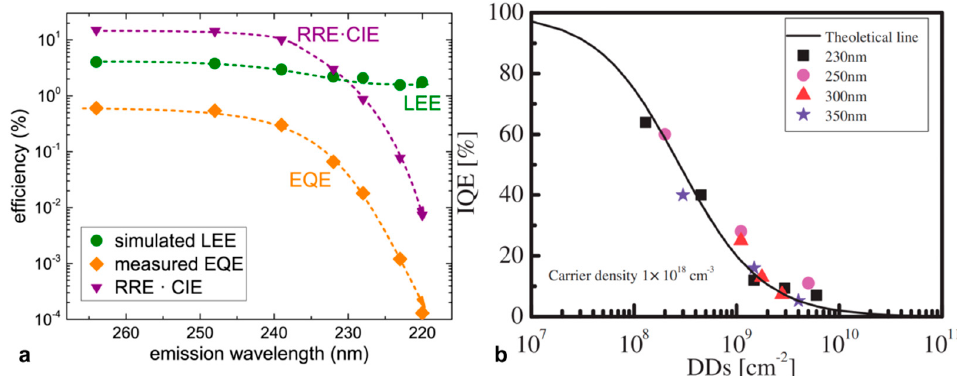
Figure 4. ( a ) Measured on-wafer EQE, simulated on-wafer LEE and corresponding product of RRE and CIE as a function of the emission wavelength [10]. ( b ) IQE as the function of DD at a weak excitation with the carrier density of 1 × 10 18 cm − 3 [39].